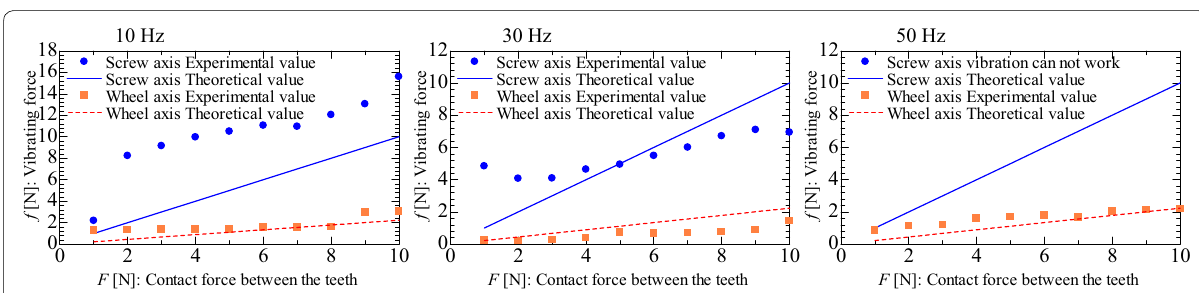
Fig. 10 Vibration force that gives backdrivability to the worm gear mechanism at each contact force between the worm screw and the worm